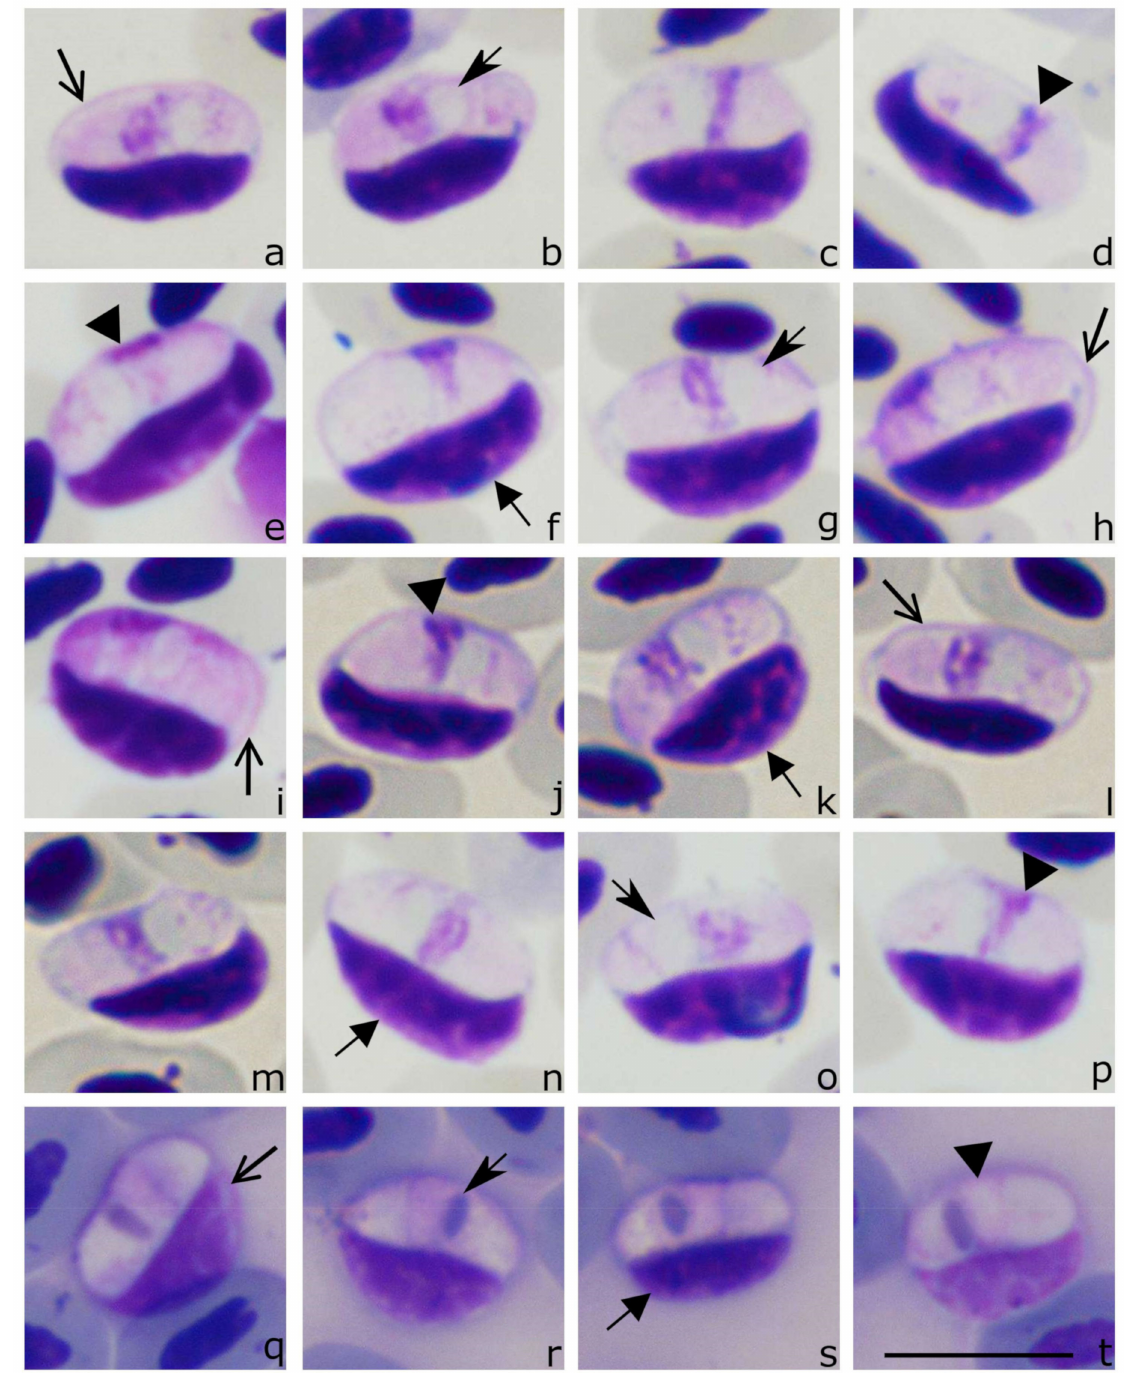
Figure 3. Sporozoites ( a – t ) of Lankesterella kabeeni 18S rRNA lineage LanAcro1 from the sedge warbler Acrocephalus schoenobaenus : images from neoparahapantotype ( a – p ) and hapantotype ( q – t , unknown lineage) are shown. Parasites develop in thrombocytes, whose host cell identity is readily distinguishable due to non-stained host cell cytoplasm and relatively thick host cell envelope ( a , h , i ). Sporozoites are closely appressed to the host cell nuclei, which are displaced to the envelope of host cells ( f , d , l ). Note the presence of a vacuole-like structure, which is closely appressed to the parasite nucleus ( b , g , j ). The parasite nucleus is of band-like shape and occupies the entire width of the sporozoite ( d , e , j ). Triangle, parasite nucleus. Short, barbed arrow, vacuole-like structure. Short triangle arrow, host cell nucleus. Simple wide arrow, host cell envelope. Scale bar: 10 µ m. Methanol fixed and Giemsa-stained ( a – p ) and Haemacolor-stained blood films ( q – t